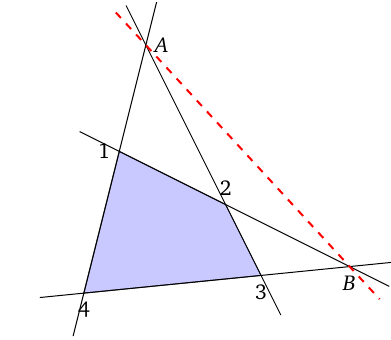
Figure 9: Intersections of the facets of the scattering facet S , associated to the 1-loop G 2-site graph, outside S . On the left, their graph realisation shows that such inter- G sections are two points. On the right, we explicitly show this scattering facet and its external triangulations. The intersections of the 1-planes containing its facets outside identify the locus of the zeroes of the canonical form (given by the red dashed line AB ). Then, the scattering facet has two triangulations, through A and B , respectively, which do not add any additional 1-plane: ( 1234 ) = ( 34 A )+( A 12 ) = ( 41 B )+( B 23 ) . There are thus two representations characterised by just physical poles, and they correspond to the OFPT and the CR